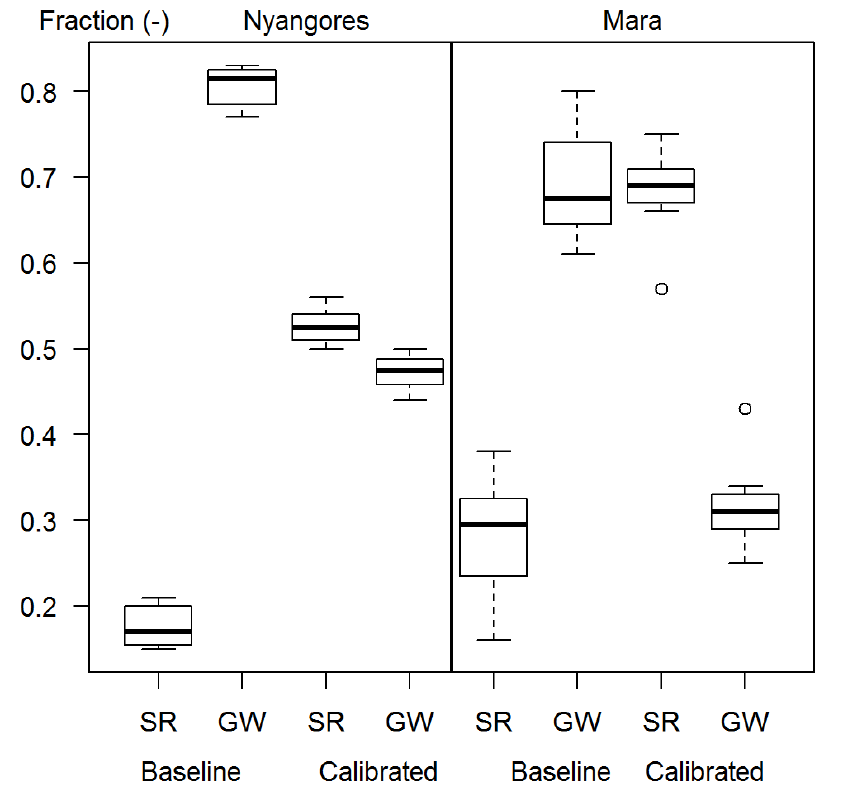
Figure 17. The surface runoff (SR) and groundwater flow (GW) contributions to the total water yield as simulated by the SWAT models.